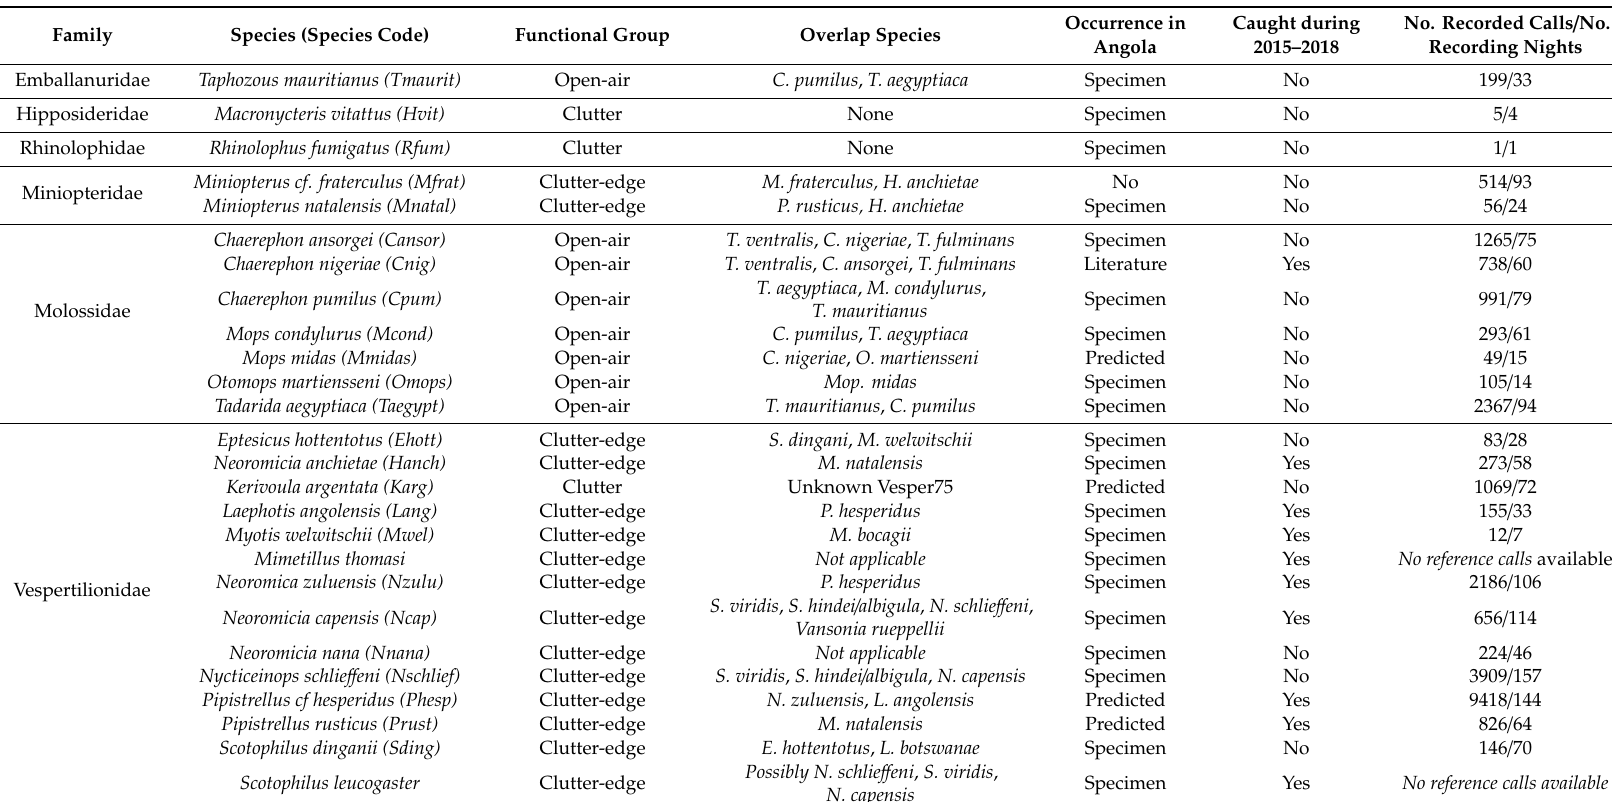
Table 1. Updated putative bat species definitions based on analysis of bat calls from surveys in the Okavango catchment of Angola between 2015 and 2018. Matching of calls with species was based on release calls from bats captured [8] and released in Angola (for Laephotis angolensis, Neoromicia capensis, Pipistrellus rusticus and N. zuluensis ) as well as [15,31,32] and unpublished data from PJT and Ara Monadjem. Species were assigned functional groups according to Monadjem et al. [15] based on their broad preferences for foraging habitats. The ‘overlap species’ refers to species that overlap in their call characteristics. Occurrence of species in Angola is shown based on evidence from specimens (based on the current survey, Global Biodiversity Information Facility (GBIF) records or listed as such by [14,15]) or only from the literature. The occurrence of a species is shown as ‘predicted’ where records are known from adjacent countries and high probabilities of occurrence were indicated for any part of Angola in maximum entropy modeling (MaxEnt for short) species models depicted in